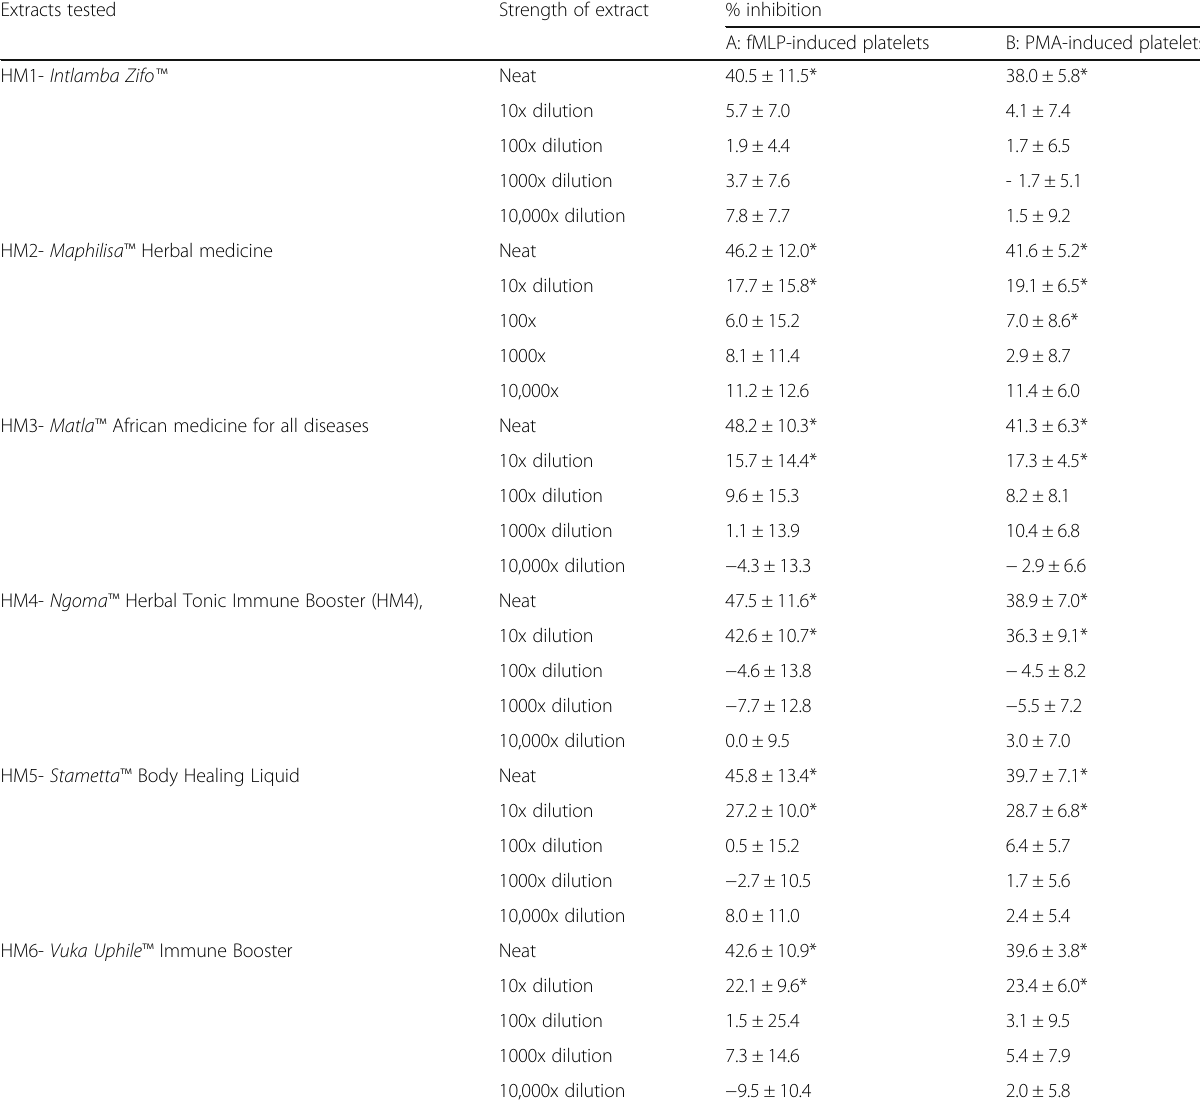
Table 2 The average % inhibitions in 60 min of platelets incubated with the HMs Extracts tested Strength of